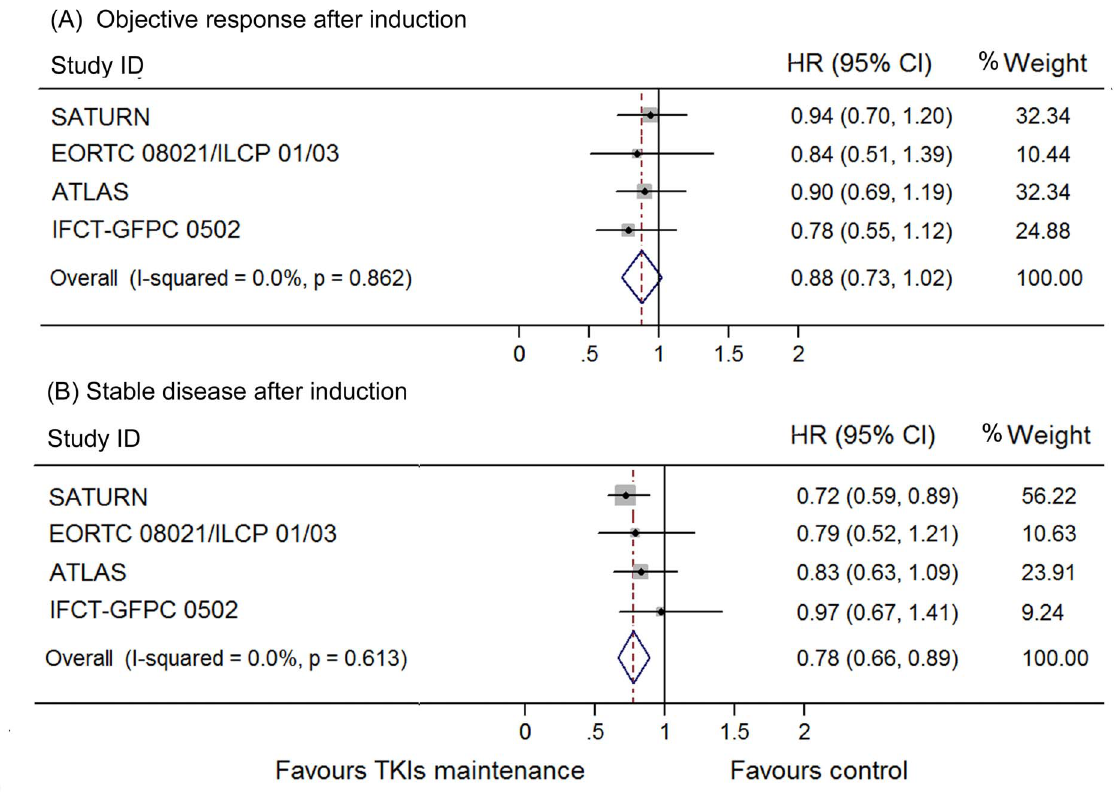
Figure 6. Meta-analysis of hazard ratio (HR) for overall survival (OS) according to histology. (A) adenocarcinoma. (B) non- adenocarcinoma.